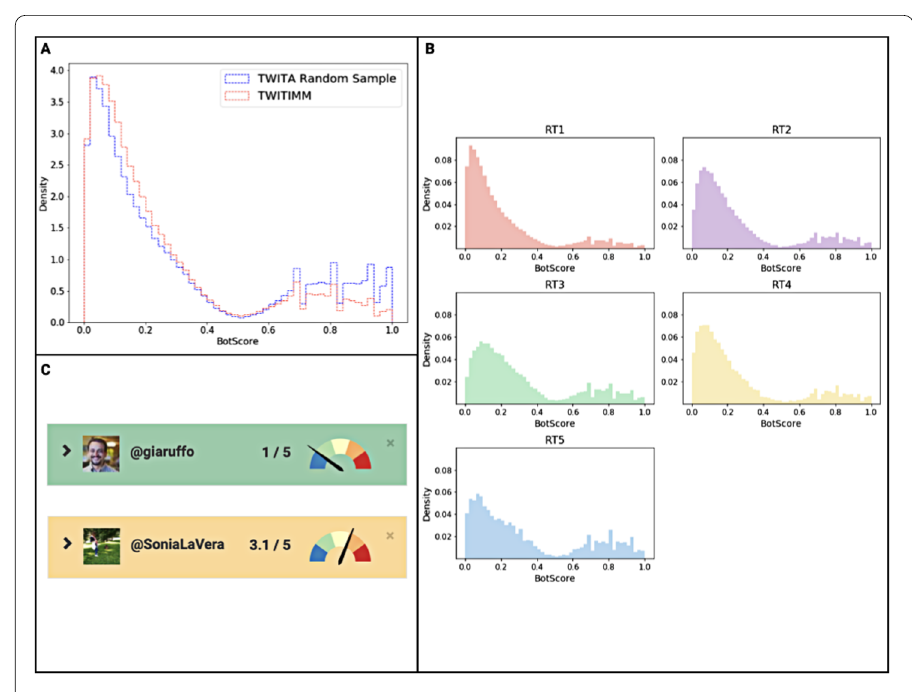
Figure 2 ( A ) Distributions of BotScores of Twitter accounts in TWITIMM, i.e., accounts involved in the immigration debate, compared to a random sample of Italian tweets produced during the same period, and equivalent in size; ( B ) BotScore distribution of all the users in the network, disaggregated by community. We can see that the right tail of the distribution—accounts showing high BotScores—is generally much lower than the left tail. This is particularly true for RT1; ( C ) Example of BotScore calculated on two different Twitter accounts: one of the authors of the paper (top) and the account with highest U of the TWITIMM dataset (bottom). Results from https://botometer.osome.iu.edu using non-raw scores that span from 0 to